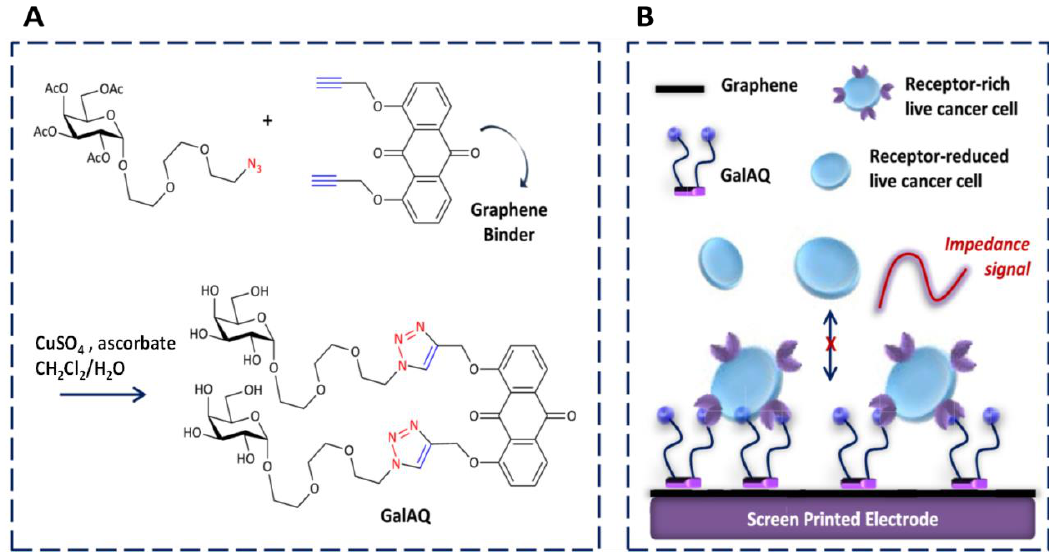
Figure 13. Synthesis of Gal-AQ ( A ) and scheme of the label-free impedance detection of receptor-rich live cancer cells ( B ). Reproduced from [66] with